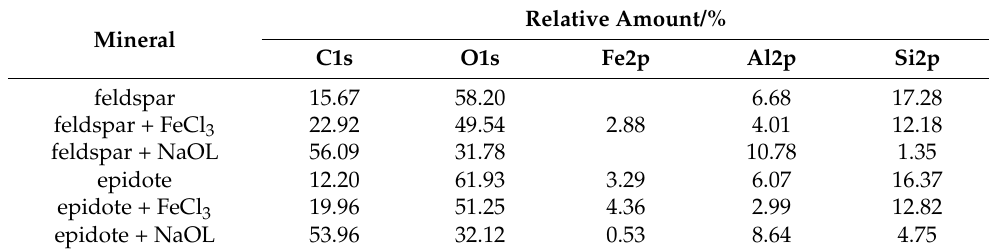
Table 3. Relative Amount of Surface Elements for